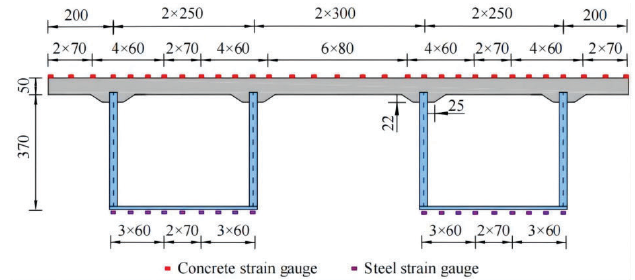
b) Corrugated steel web of model c) One half of composite box girder